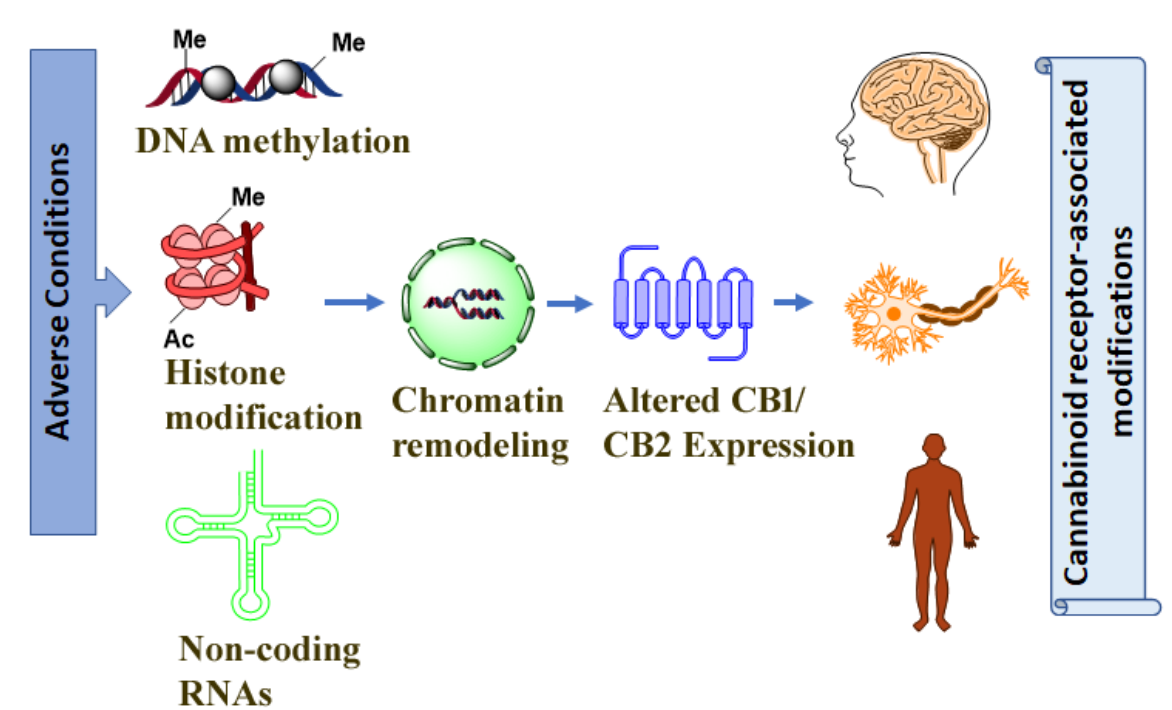
Figure 1. Epigenetic mechanisms epitomize important gene–environment relation mediators behind many human disorders’ pathogenesis. Various adverse conditions such as drug abuse, including alcohol, cannabinoids, and adverse developmental conditions may potentially affect the expression of genes such as cannabinoid receptors, causing the altered functions, at least through epigenetic modifications.